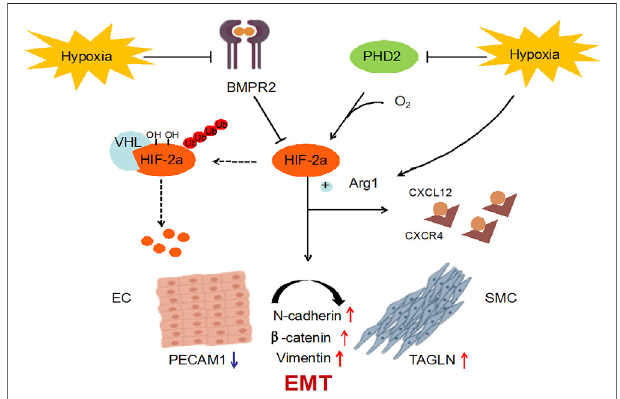
FIGURE8| Polydatin improvesMCT-induced PAH byinhibiting